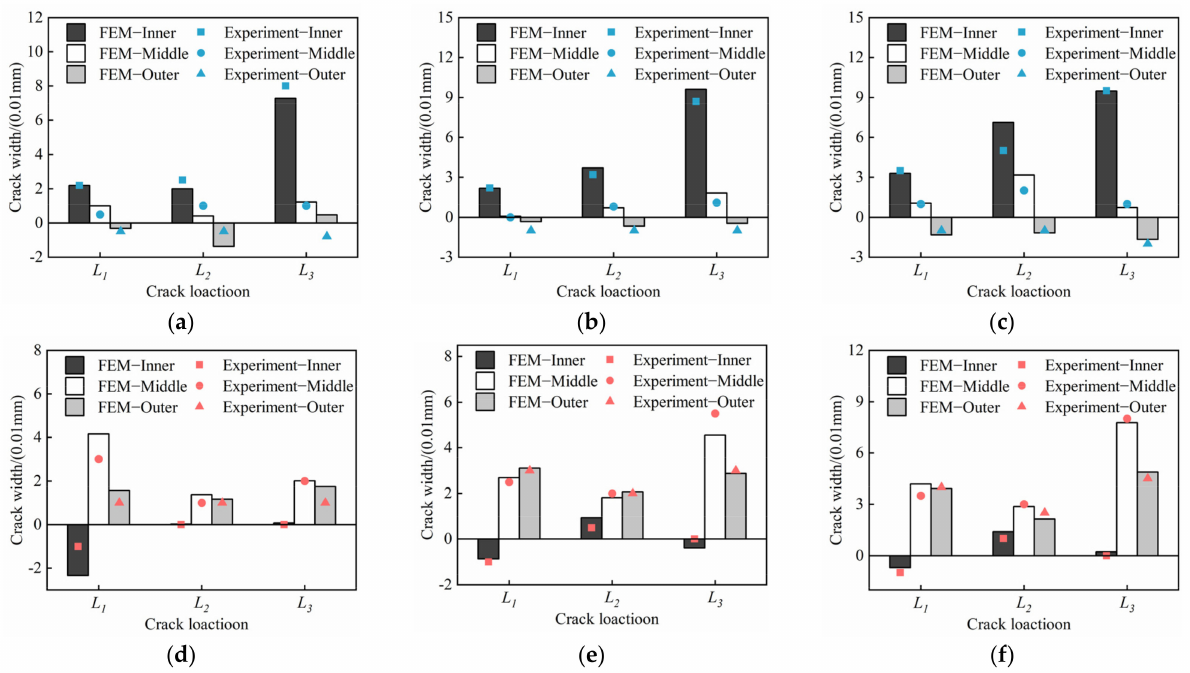
Figure 14. Crack propagation in thermomechanical cohesive zone model: ( a ) crack distribution; ( b ) calculation theory of the crack width.